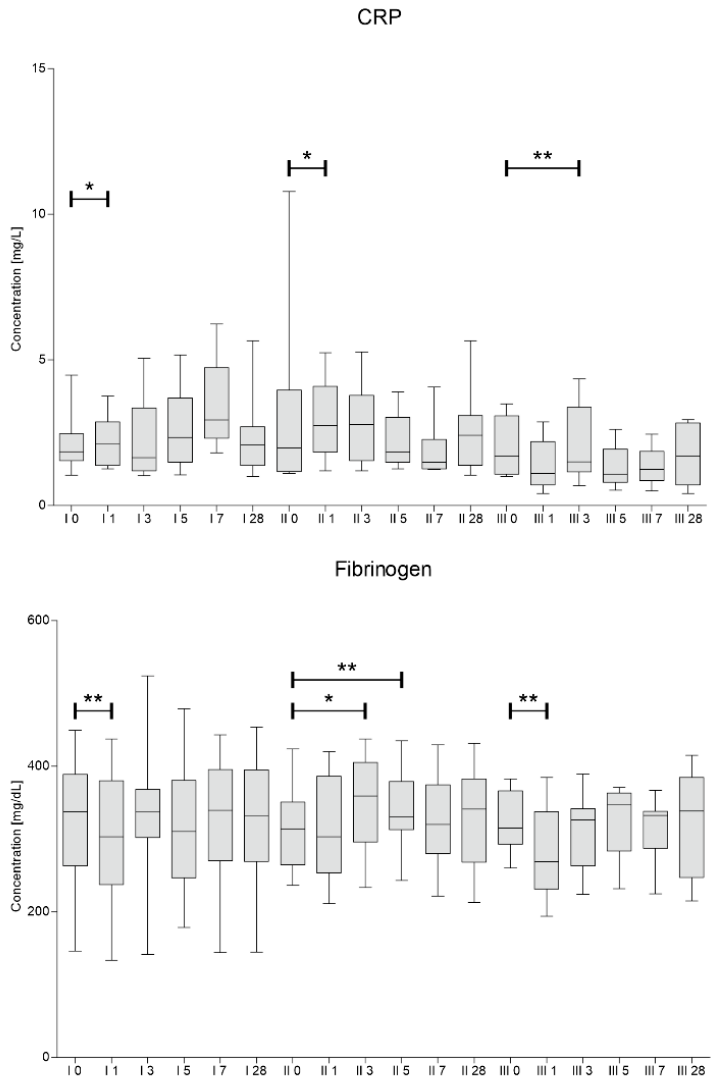
Figure 4. C-reactive protein and fibrinogen median concentrations assessed on days 0, 1, 3, 5, 7 and 28 for each of three cells administration procedures (I, II, III). Significance of the changes between analyzed timepoints in comparison to day 0 of each administration was assessed using Wilcoxon signed-rank test. Level of significance—* p < 0.05, ** p < 0.001.